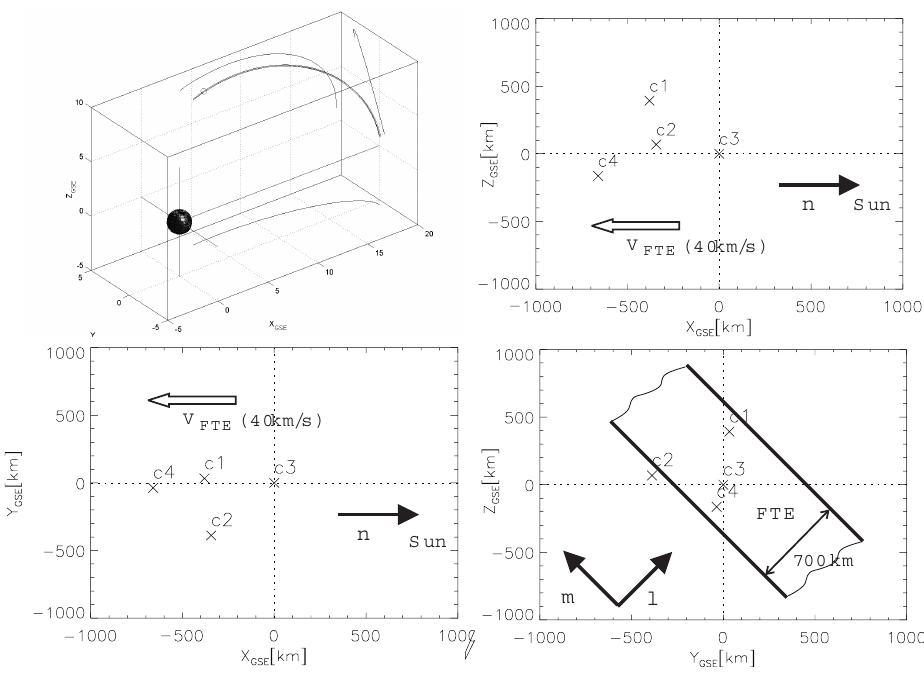
Fig. 9. The geometrical configuration for the four Cluster spacecraft on 3 March 2001 (upper left panel). Spacecraft positions relative to spacecraft 3 in GSE-coordinates at 00:46 UT (beginning of the first grey shaded internal of Fig. 8). The boundary normal coordinate system ( l,m,n ) is marked by the solid arrows, the velocity component of the FTE motion V FTE is marked by an open arrow. Furthermore, a schematic plot of the FTE in the Y − Z -plane is